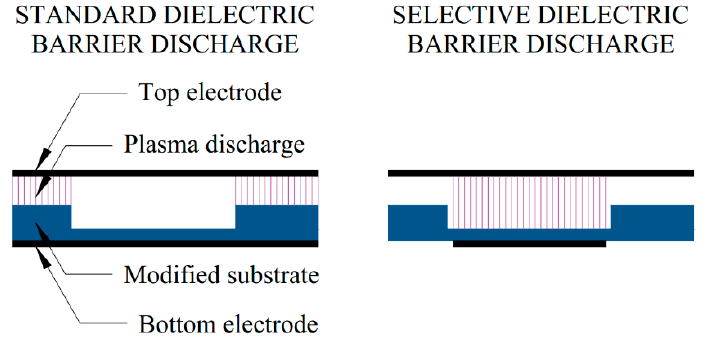
Figure 9. Application of the Selective Dielectric Barrier Discharge for bonding PDMS in cavities, which is difficult to obtain in a non-selective set-up.